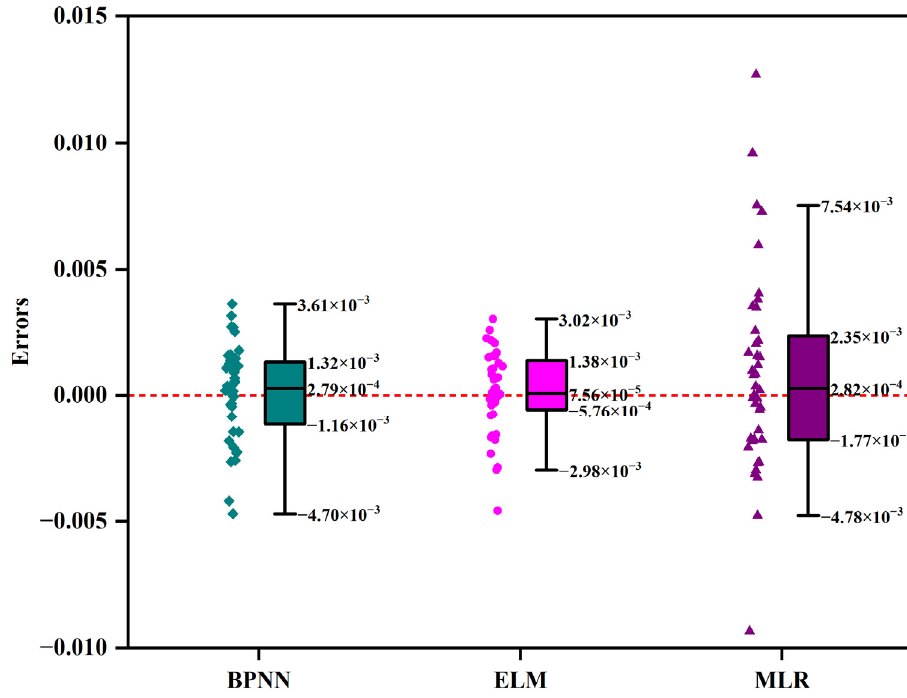
Figure 15. The boxplot of errors distribution of the three developed models in the test stage.